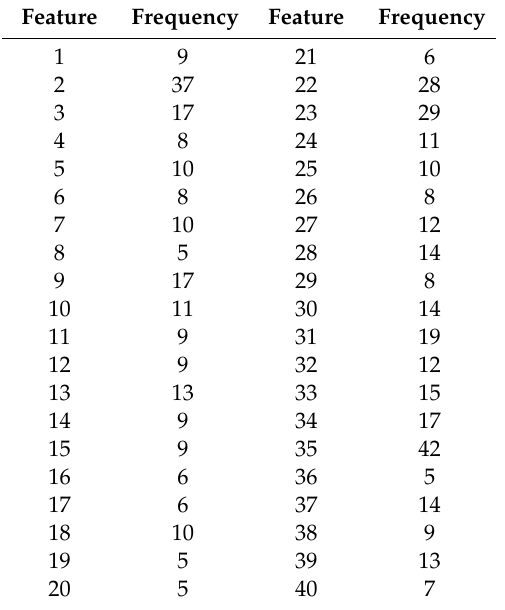
Table 14. Frequency of each